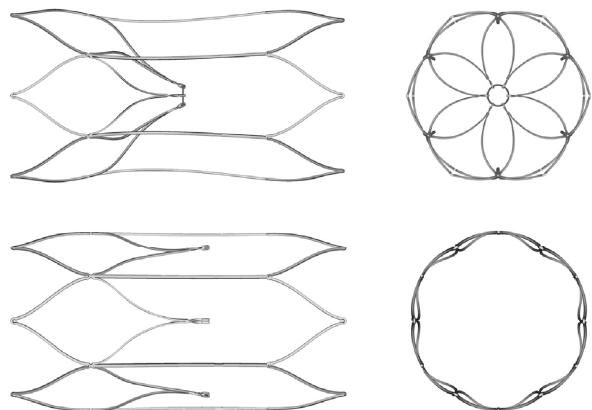
Figure 1: The Sentry bioconvertible IVC filter in filtering (above) and bioconverted (below) configurations, with corresponding axial views on the